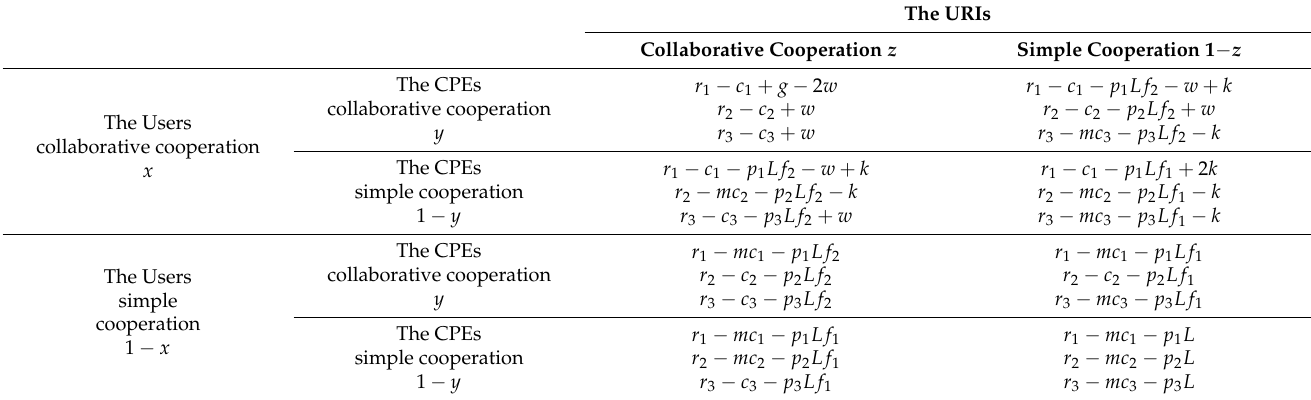
Table 3. Technological innovation cooperation in MCPs game gain